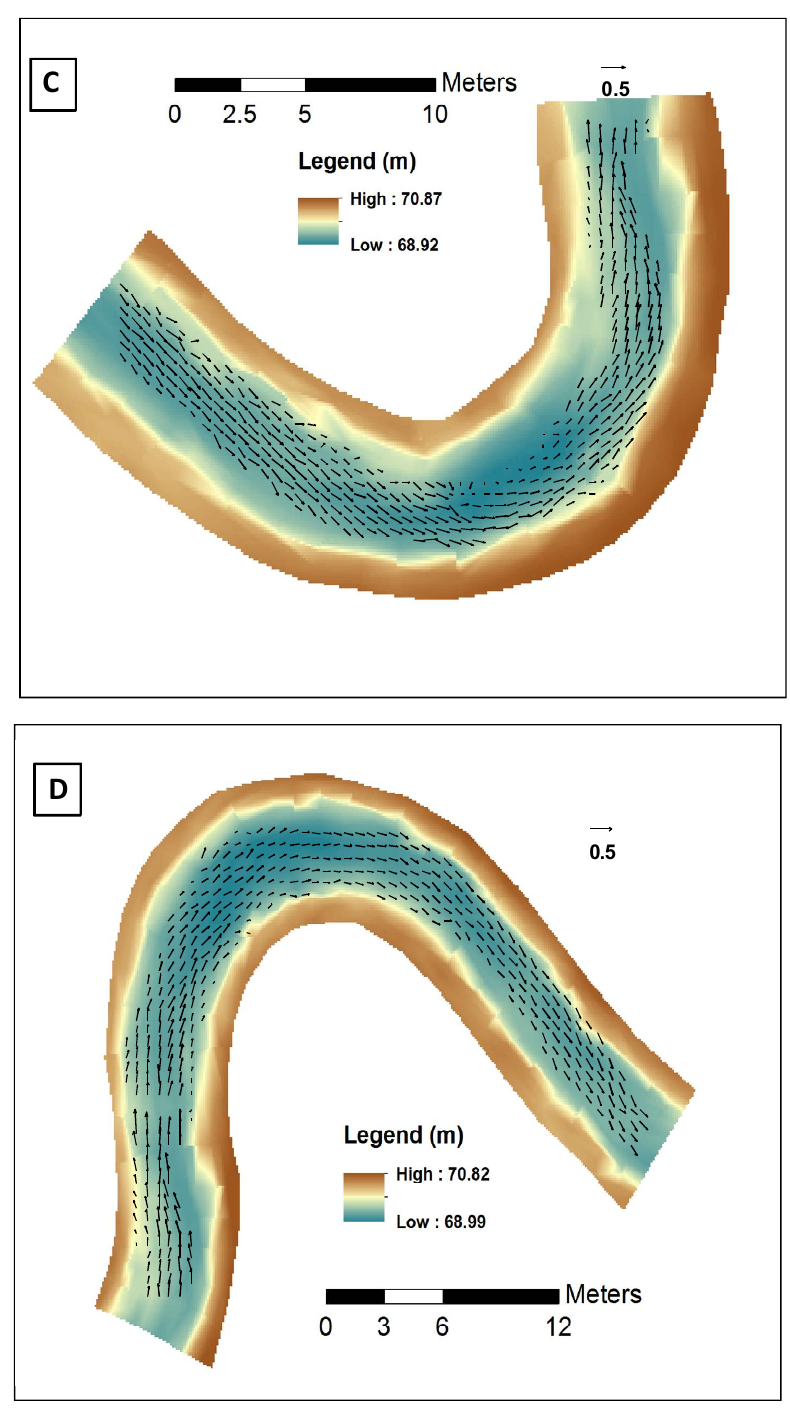
Figure 11. Measured depth-averaged ADCP velocities in the meander bends of the M3 sub-reach at: ( a ) first bend during August 2014 (low flow) ( b ) second bend during August 2014 (low flow) ( c ) fist bend during October 2014 (moderate flow) ( d ) second bend during October 2014 (moderate flow). Refer to Figure 1c for location of these bends. Surveyed bathymetric data (2014) are shown in the background.